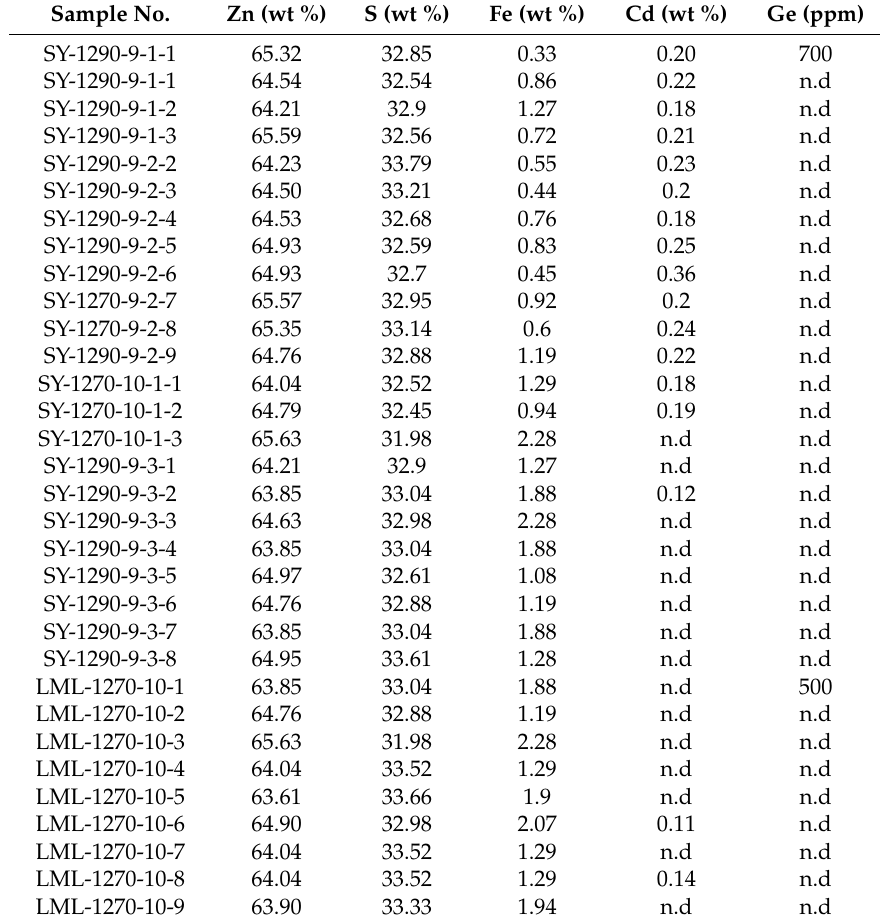
Table A1. EMPA results of Sphalerite from the Nayongzhi